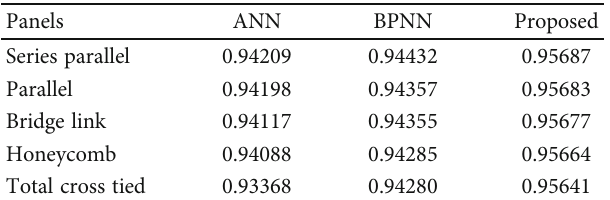
Table 1: Accuracy.